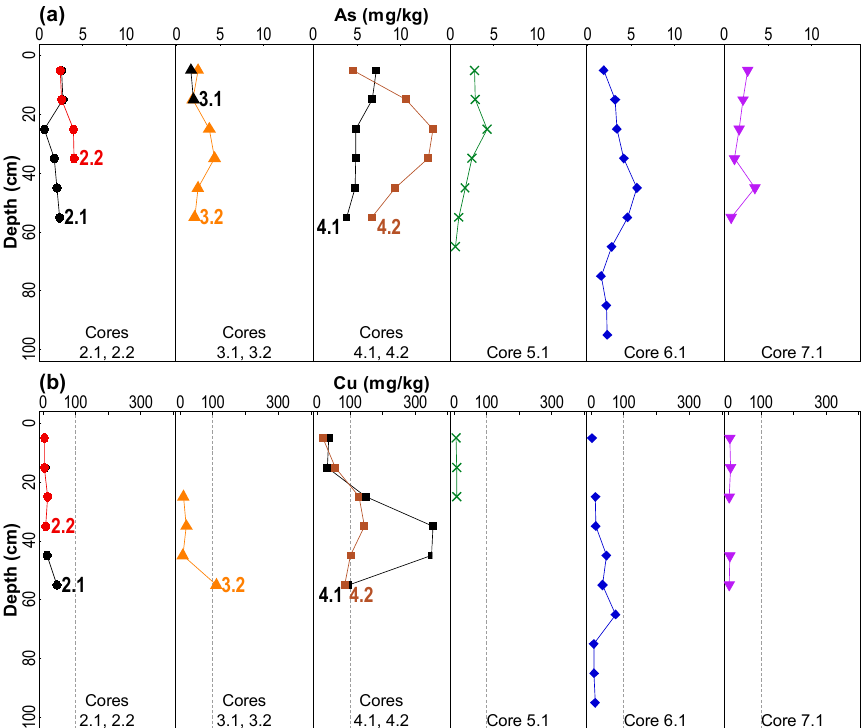
Figure 9. Depth profiles of ( a ) arsenic (As) and ( b ) copper (Cu) in soil cores collected from Smith’s Lake and Charles Veryard Reserves, City of Vincent, Western Australia. Core locations from Figure 1. Ecological investigation limits (EIL) are shown as vertical dashed lines where relevant.